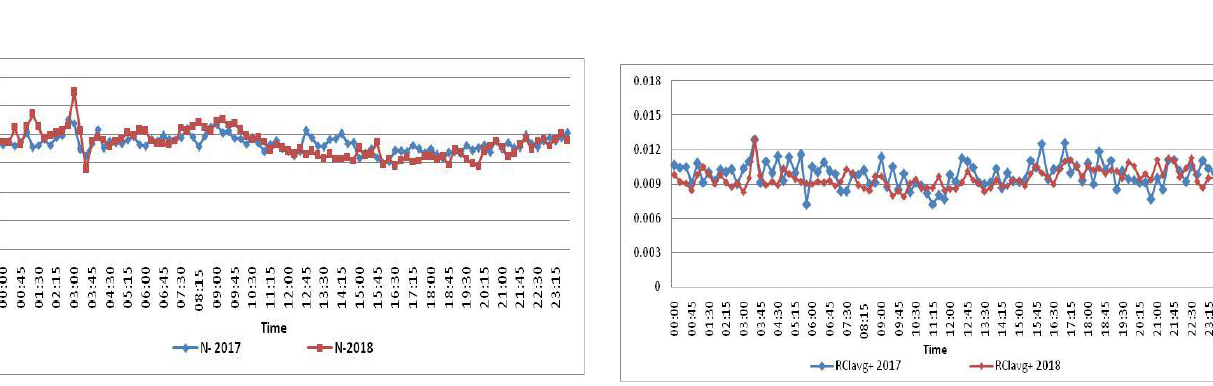
Figure 10. Comparison between RCIs for the average of upward power ramps in 15 min interval at each observation time t for the years 2017 and 2018.